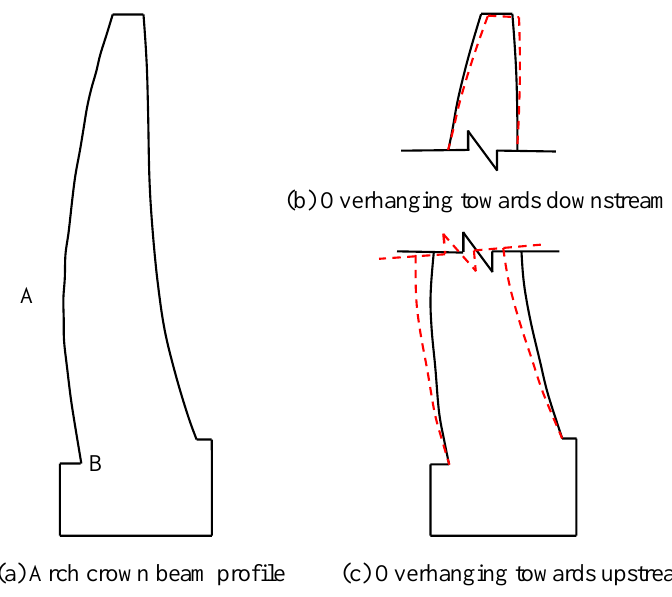
Figure 4. Dam-overhanging effect of the double-curvature arch dam. The dam-overhanging effect mainly occurs during the construction period. For hy- perbolic arch dams of medium and low heights, deformation monitoring instruments are installed after grouting, by which time the overhanging effect has been basically released. Therefore, there is a lack of monitoring data to analyze the effect of the overhanging effect on the deformation state of the arch dam. However, in the alpine and gorge regions of Southwest China, super-high arch dams are built in stages, and deformation monitoring instruments are installed earlier. For example, the plumb-line monitoring instruments for the Xiluodu super-high arch dam were installed during the dam construction period, with the typical time nodes shown in Figure 5. In addition, the Xiaowan arch dam was